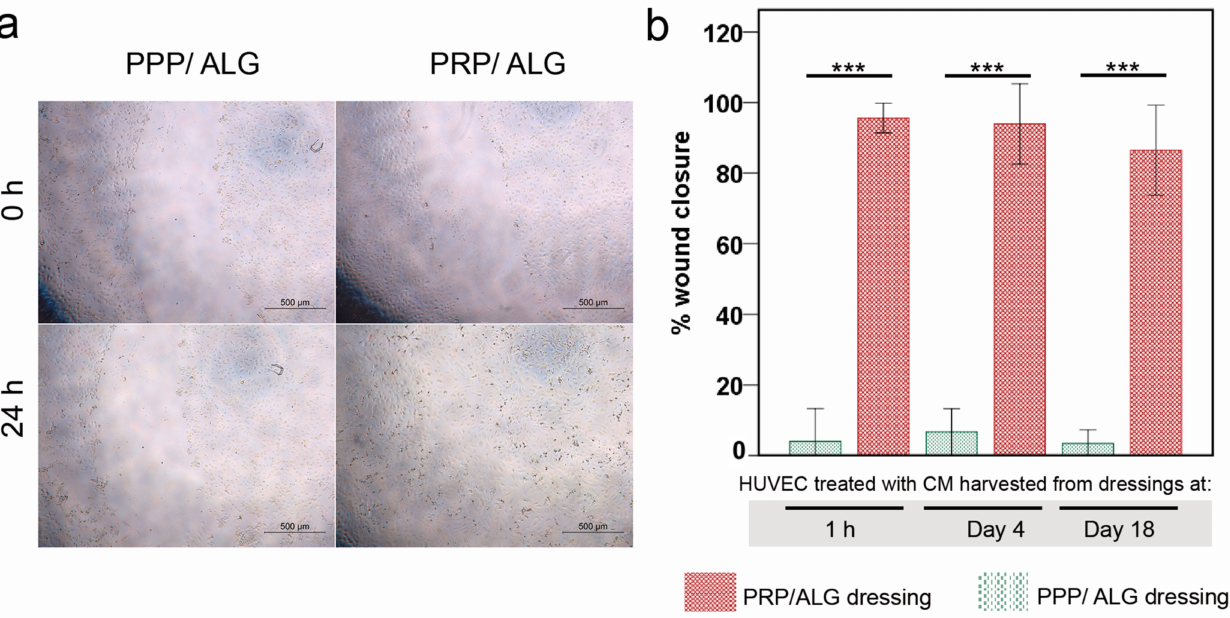
Figure 9. Scratch wound-healing assay on HUVECs treated with CM from PPP and PRP (1 h and days 4 and 18). ( a ) Photomicrographs illustrating differences in HUVEC migration at 0 h and after 24 h of exposure. CM. Original magnification, 10 × . Scale bar, 500 µ m. ( b ) Percentage of wound closure among HUVECs exposed to CM from PRP/ALG (red) and PPP/ALG (green) dressings harvested at 1 h, 4 days, and 18 days after bioprinting. *** p < 0.0001. CM, conditioned media; HUVEC, human umbilical vein endothelial cell; ALG, alginate; PRP, platelet-rich plasma; PPP, platelet-poor